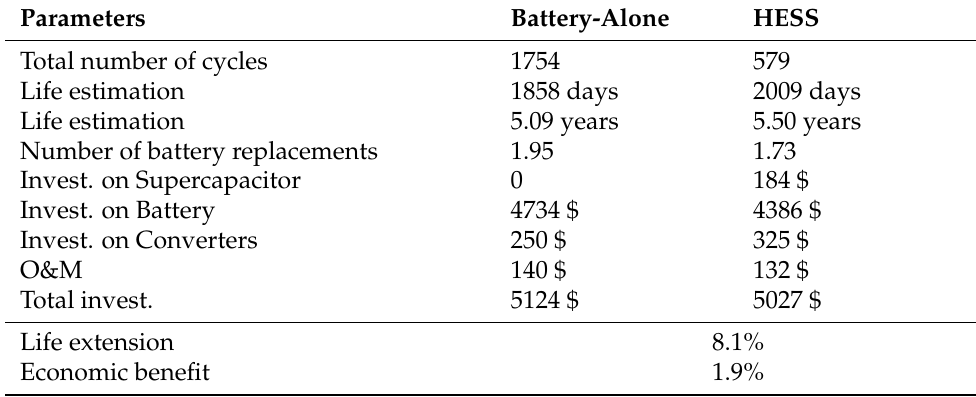
Table 6. Results of the base